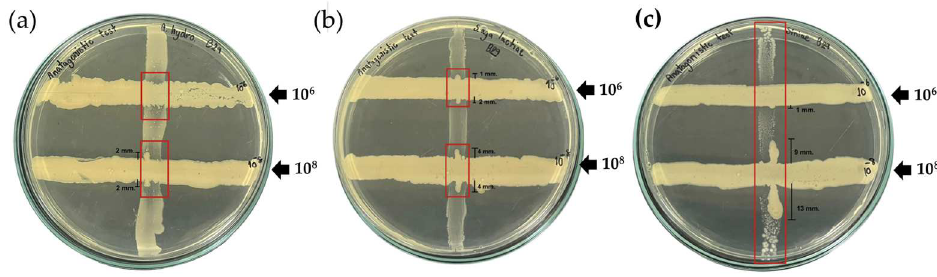
Figure 1. Inhibitory and/or colonization activities of 1 × 10 6 and 1 × 10 8 CFU/mL of Bacillus isolate B29 against: ( a ) A. hydrophila ; ( b ) S. agalactiae ; ( c ) S. iniae at 72 h. The red box indicated